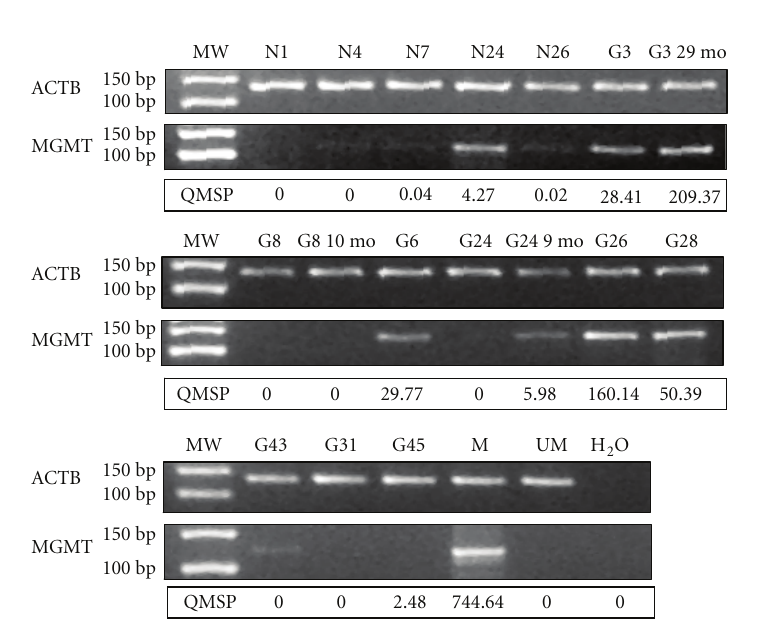
Figure 3: Comparison of QMSP analysis MSP . Representative results of Methylation-Specific PCR analysis and comparison with Quantitative Methylation-Specific PCR. As control of the bisulphite conversion the upper panels show PCR reactions specific for the ACTB gene promoter region not containing CpG; the middle panels show PCR reactions specific for the methylated sequence of the MGMT promoter; lower panels show results of QMSP. MW: Molecular weight marker. M, positive control (CpGenome Universal Methylated DNA); UM: Negative control (Universal Unmethylated DNA); N: Normal brain tissue; G: Glioma sample. Normal brain tissues N4, N7, N26 and snap-frozen tumour sample G43 show faint bands in the gel electrophoresis but MGMT / ACTB ratios below the cuto ff value of 0.35 by QMSP, snap-frozen sample G45 show no methylated band by MSP but an MGMT / ACTB ratio above the cuto ff value of 0.35 by QPCR.